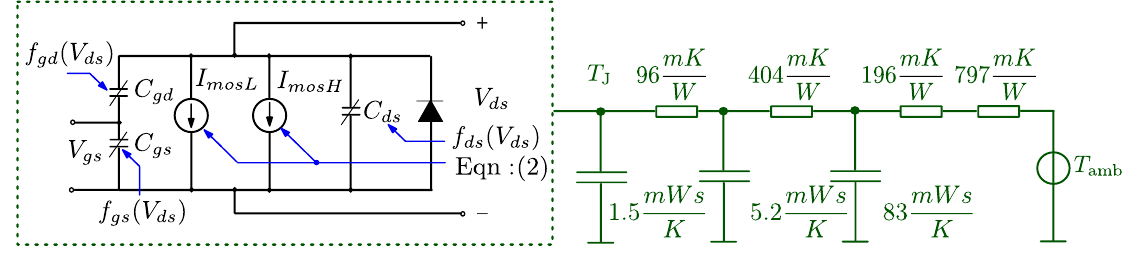
Figure 4. Equivalent electro-thermal model based on an 1200 V SiC power MOSFET with TO-247 package.